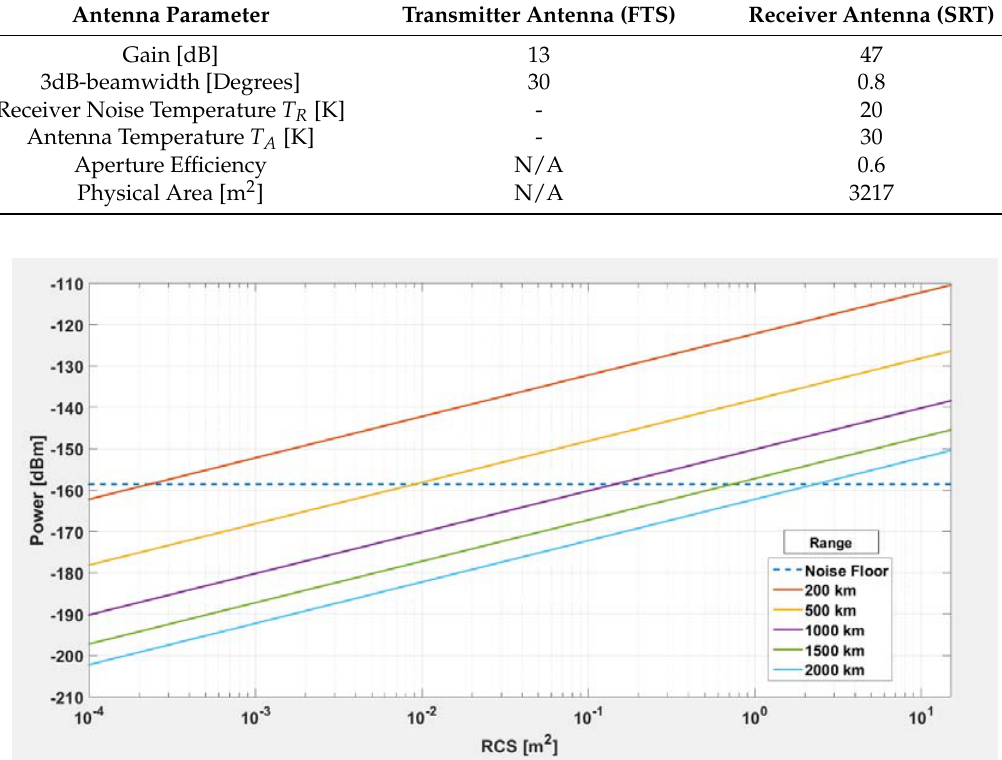
Figure 2. Back-scattered power at the receiver antenna (SRT) as a function of the RCS of the object to be detected with the BIRALET system, for different values of the range from the SRT at 410 MHz.